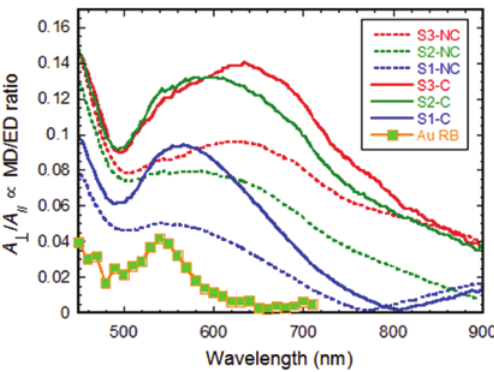
/ A as an estimator ⊥ //